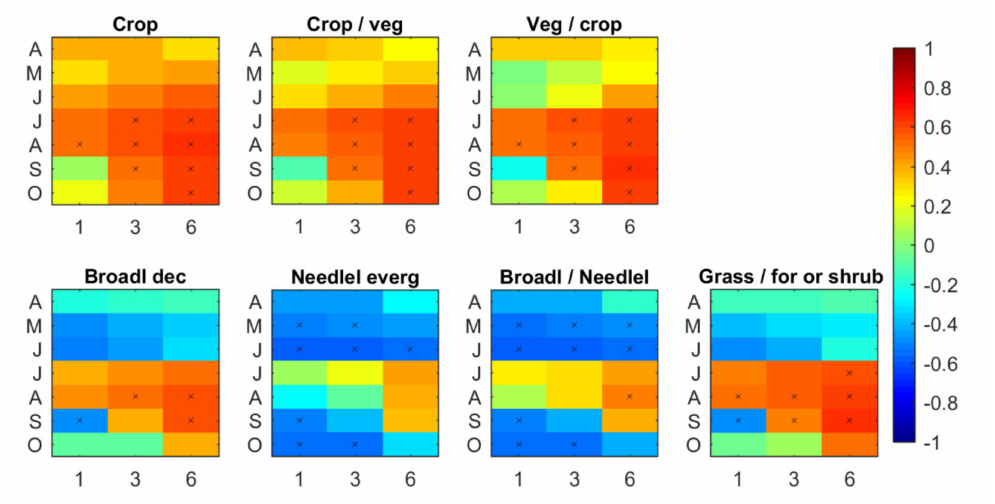
Figure 5. Mean value of the significant correlations between detrended NDVI and SPEI for the months from April to October and time scales of 1, 3 and 6 months. The X symbol corresponds to a standard deviation lower than 0.2. Only land cover classes covering more than 1% of the area are